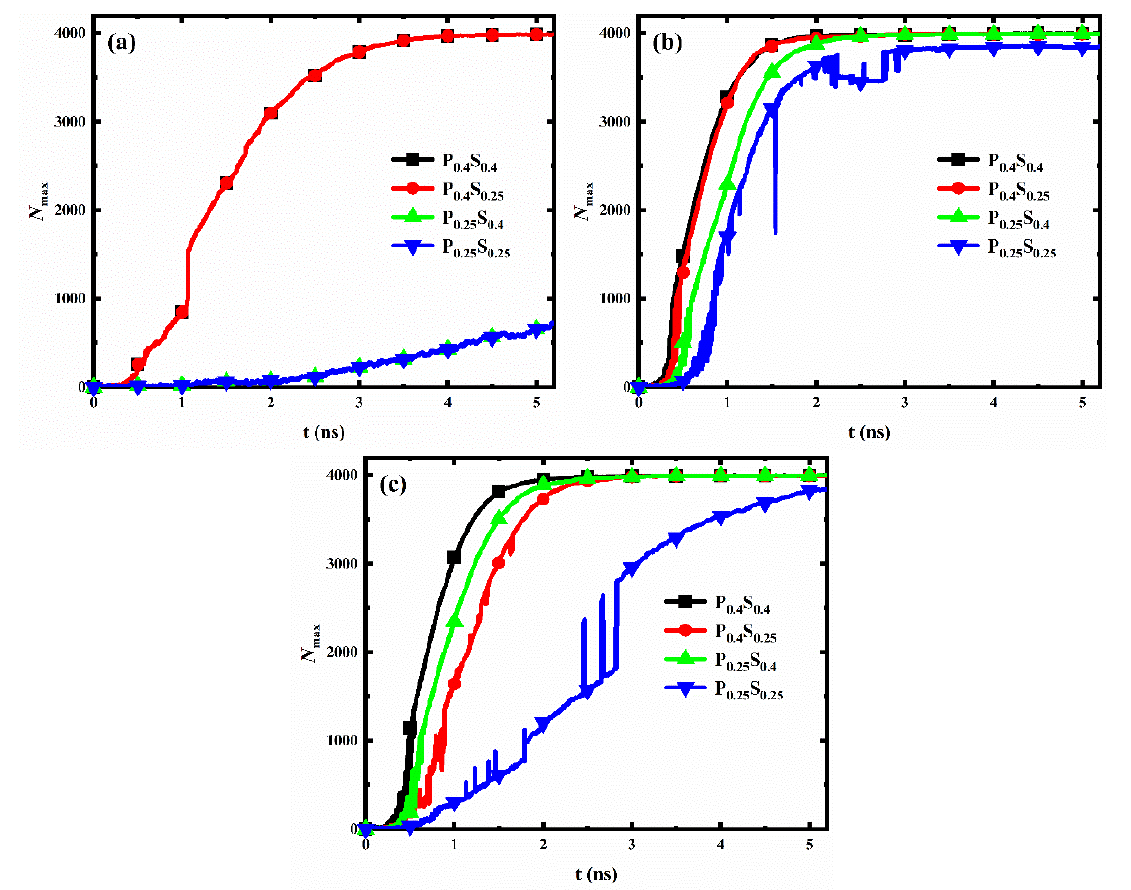
Figure 10. The evolution of the number of water molecules in the largest size cluster for nanopillar surfaces with different wettability distributions. The interpillar spacing of the surface is ( a ) D 1 ; ( b ) D 2 ; ( c ) D 3 .